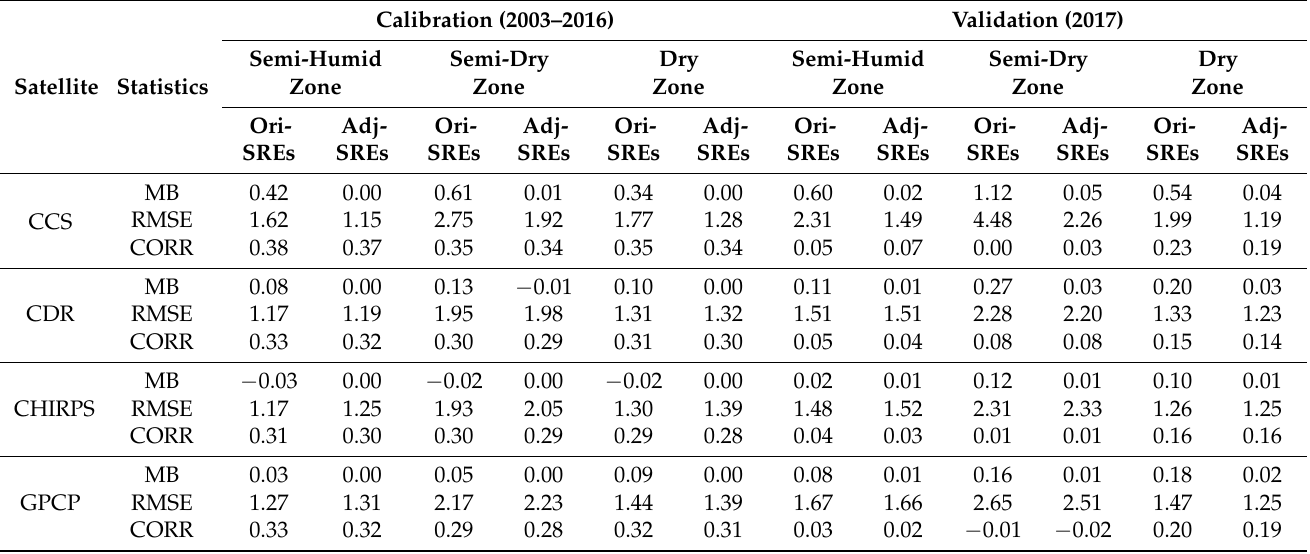
Table 3. Daily time series evaluation